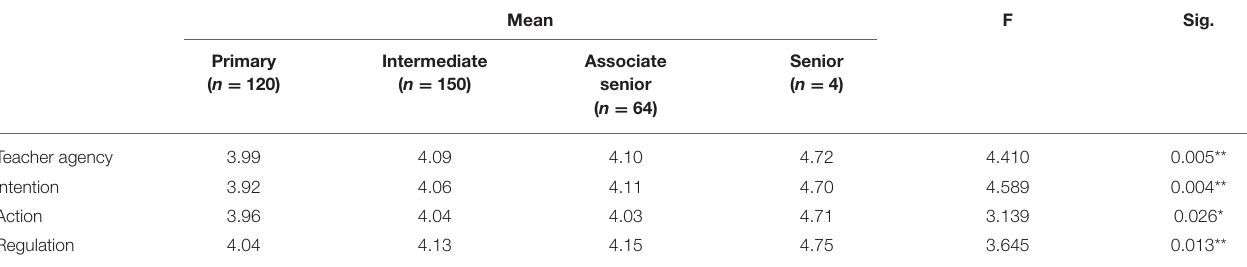
TABLE 2 | Teachers’ agency differences among professional titles. Mean F Sig.